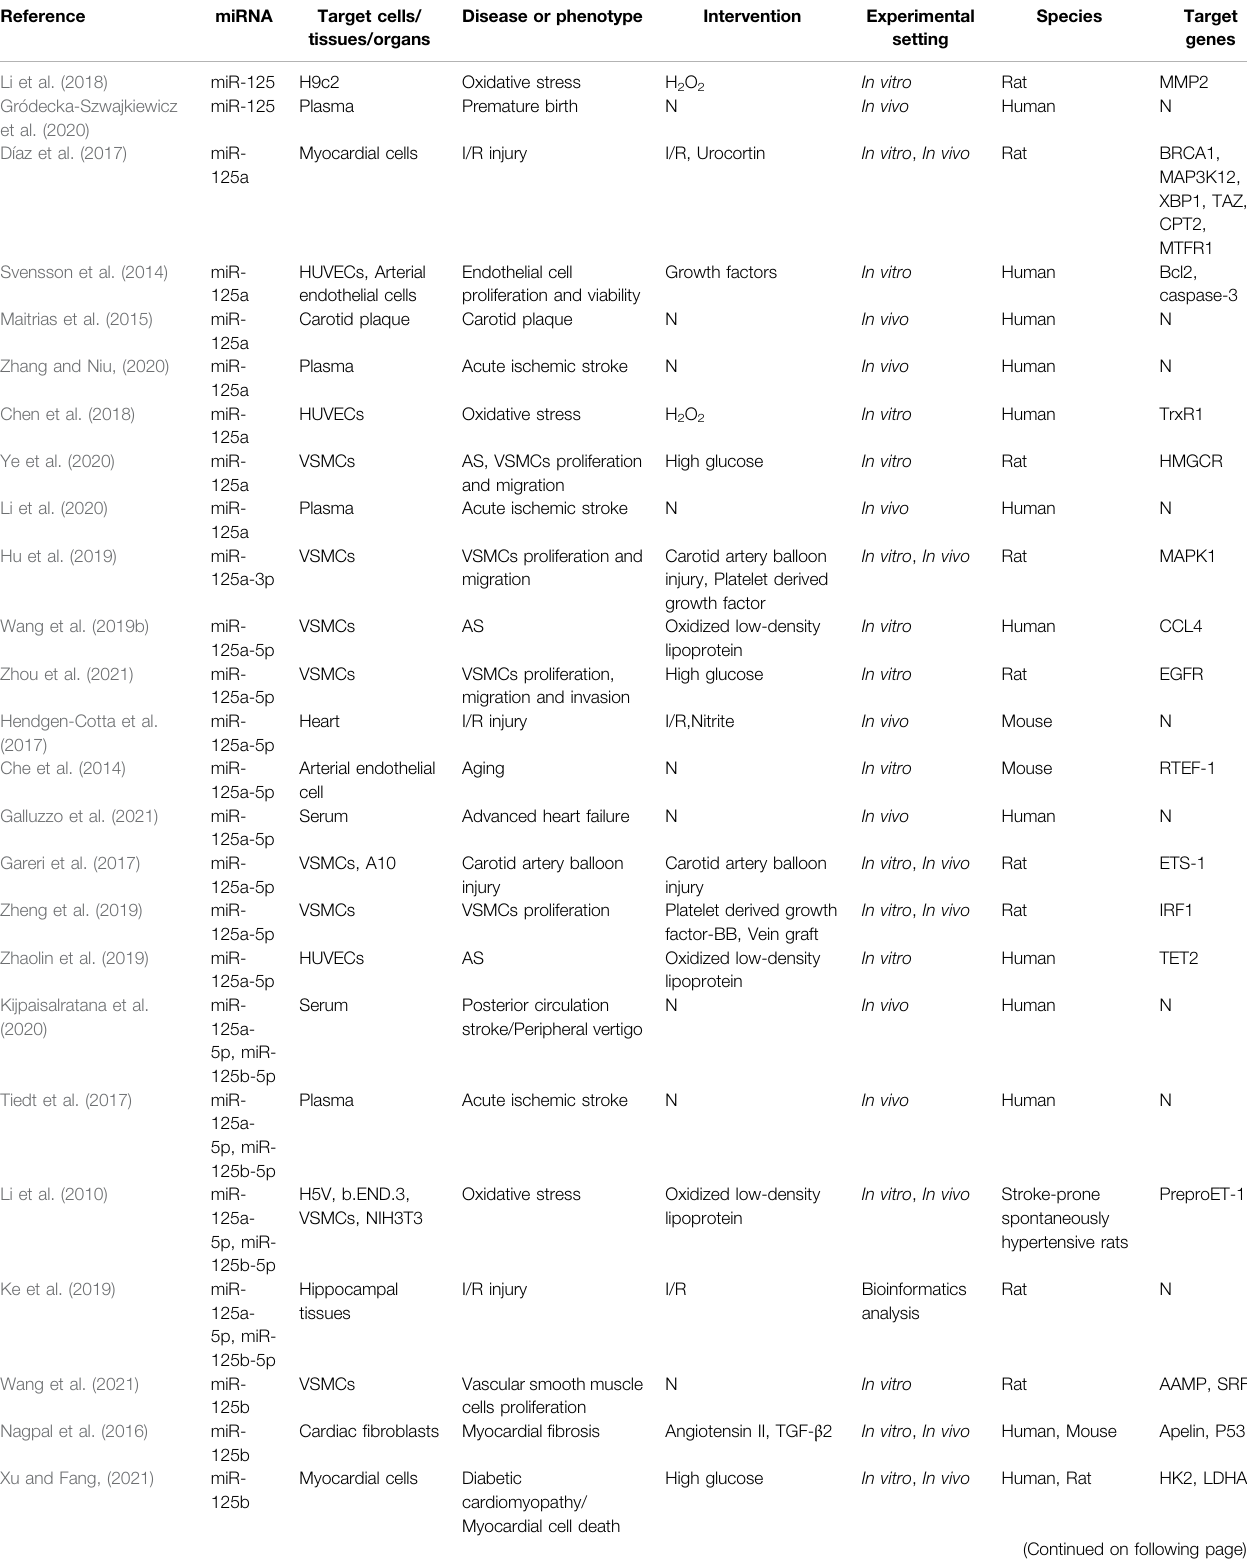
TABLE 1 | Summary of studies investigating the regulators and effectors of miR-125 family in cardiovascular and cerebrovascular diseases.